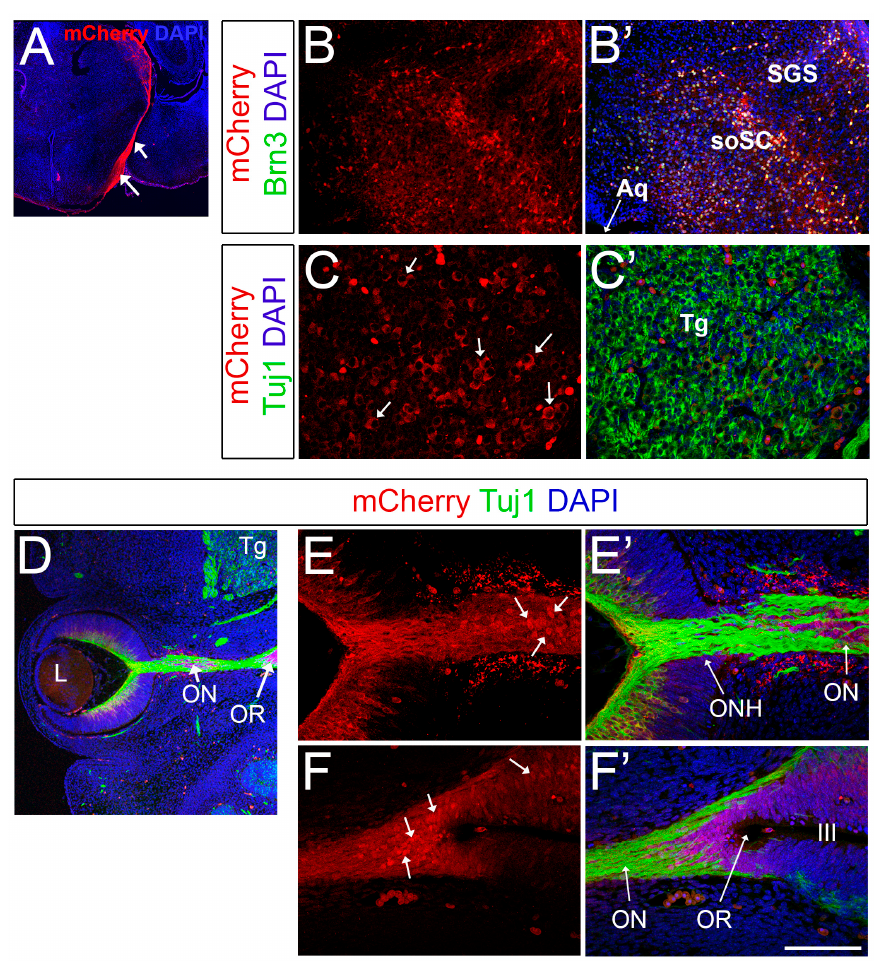
Figure 4. Brn3b-mCherry expression in other regions of the CNS. ( A ) Optic tracts at P0 visualized by mCherry staining (white arrows). ( B , B’ ) Co-localization experiments with mCherry (red) and pan-Brn3 (green) antibodies at P0. ( C , C’ ) Co-localization with mCherry (red) and Tuj1 (green) in the trigeminal ganglia at E13.5. Arrows indicate mCherry + Tuj + neurons. ( D ) Low magnification image of a horizontal E13.5 whole-head section. E – F’ ) White arrows indicate mCherry + Tuj1- cells present in the optic stalk ( E ) and optic recess ( F ). Aq: Aqueduct. soSC: stratum opticum of the Superior Colliculus. SGS: Stratum Griseum Superficiale. Tg: Trigeminal ganglion. L: Lens. ONH: Optic Nerve Head. OR: optic recess. III: 3rd ventricle. Scale bar: 100 microns in C,C’, E,E’ and F,F’, 200 microns in B,B’, 300 microns in D, and 500 microns in A.